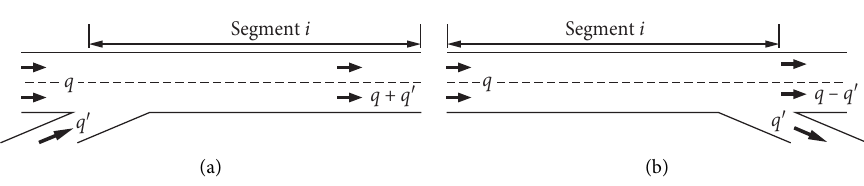
Figure 5: Analysis of traffic flow of on-ramp and